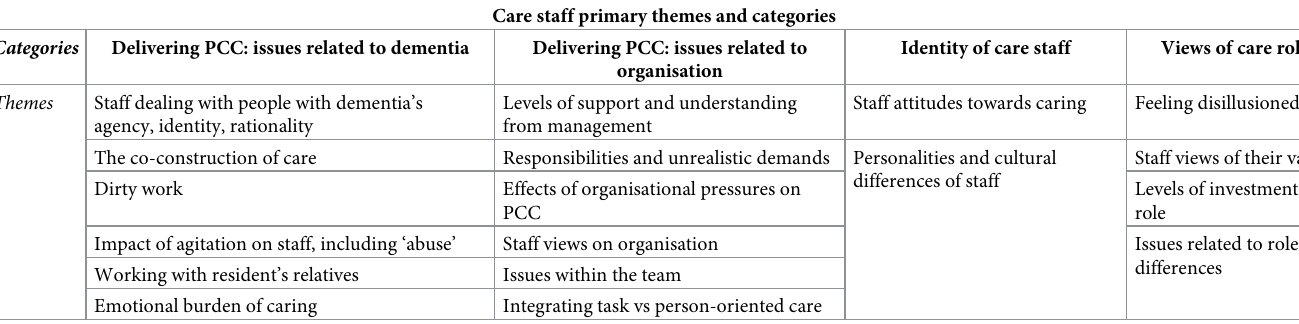
Table 3. Care staff primary themes and categories.